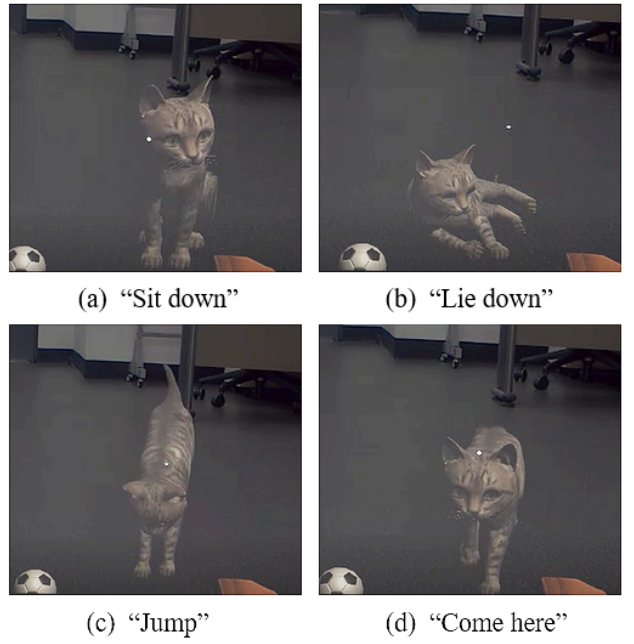
Figure 4. Examples of interaction with voice